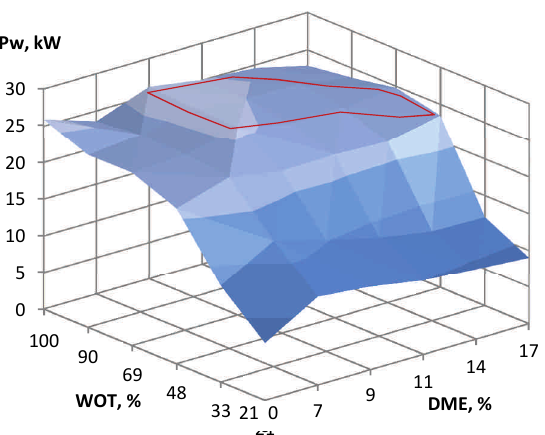
Fig. 9. The results of power on wheel measured during experimental test; n = 2500 rpm